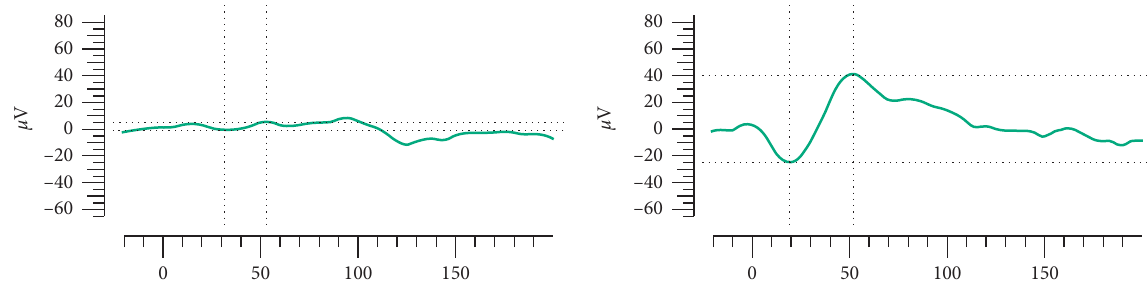
Figure 4: Electrophysiological examination. Almost no respondence was recorded in the right eye, and there was obvious decrease of amplitude in the left eye in